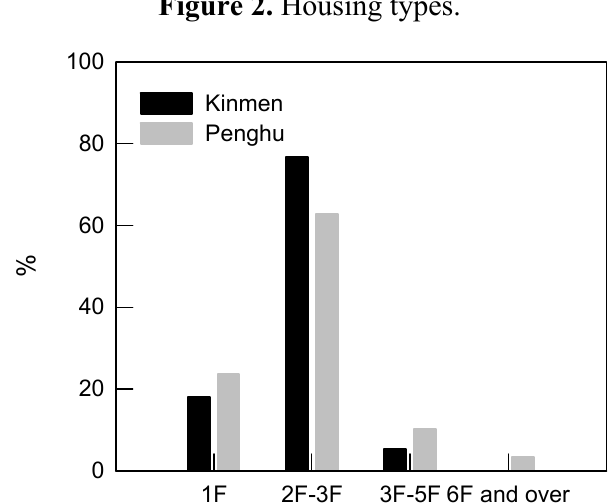
Figure 2. Housing